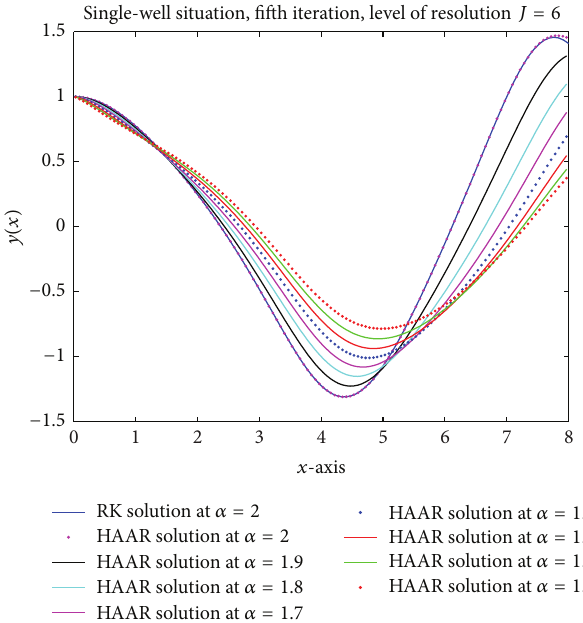
Figure 1: Solution by RK method (RK Solution) at 𝛼 = 2 and solution by Haar wavelet-quasilinearization technique (HAAR Solution) at 𝐽 = 6 and different values of 𝛼 for 𝑎 = 0.5 , 𝑏 = 0.5 , 𝜇 = 0.1 , 𝑓 = 0.5 , and 𝜔 = 0.79